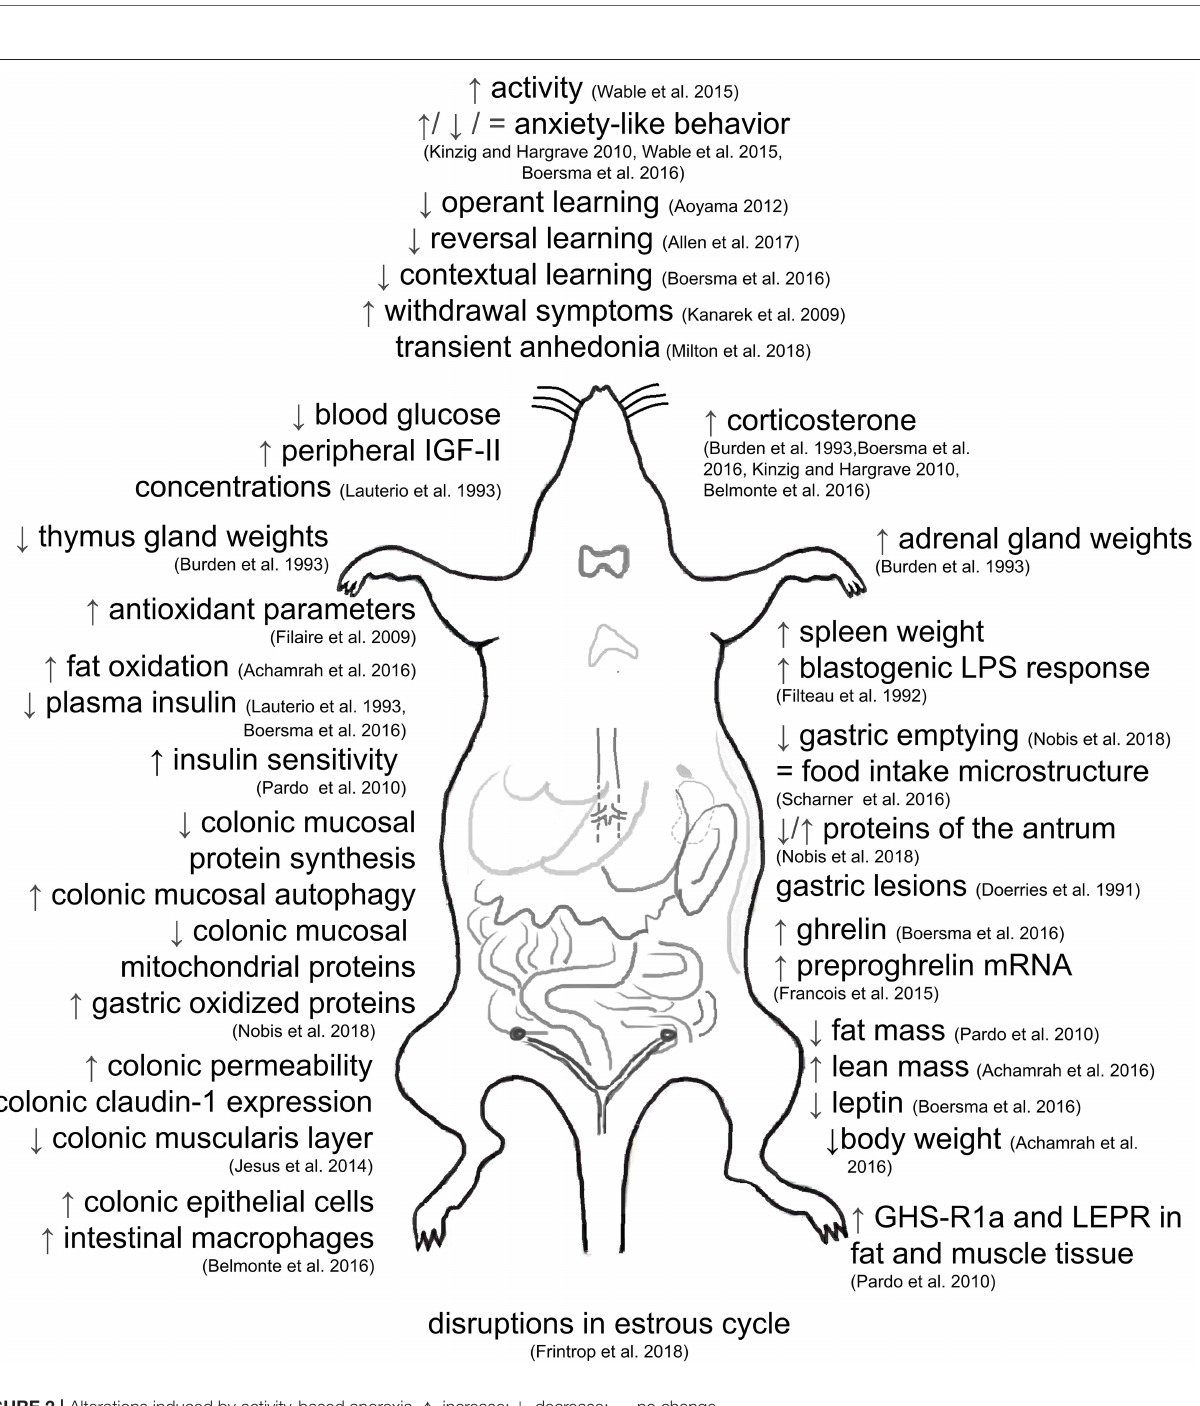
FIGURE 2 | Alterations induced by activity-based anorexia. ↑ , increase; ↓ , decrease; = , no change.